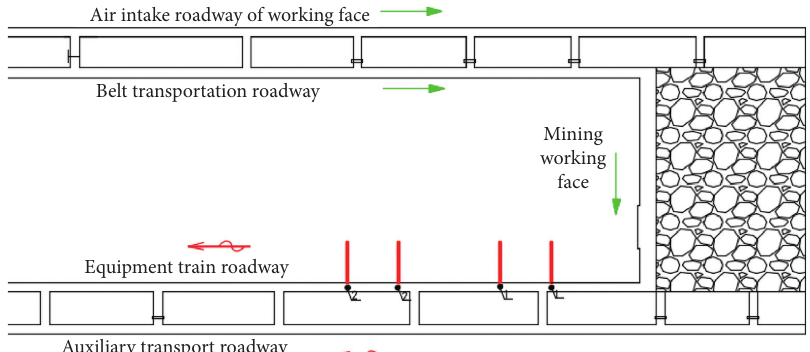
Figure 9: Monitoring point layout